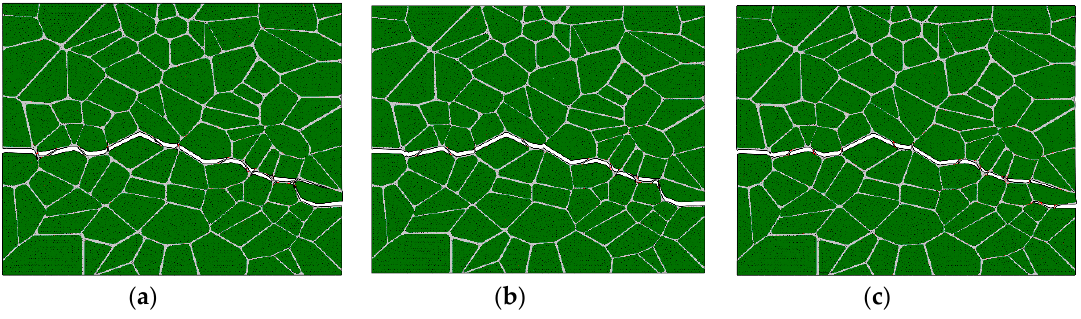
Figure 18. Crack path of PBX 9501 under uniaxial tension at a strain rate of 10 − 3 s − 1 for different interface cohesive strengths: ( a ) 1 MPa, ( b ) 1.66 MPa, and ( c ) 3 MPa.